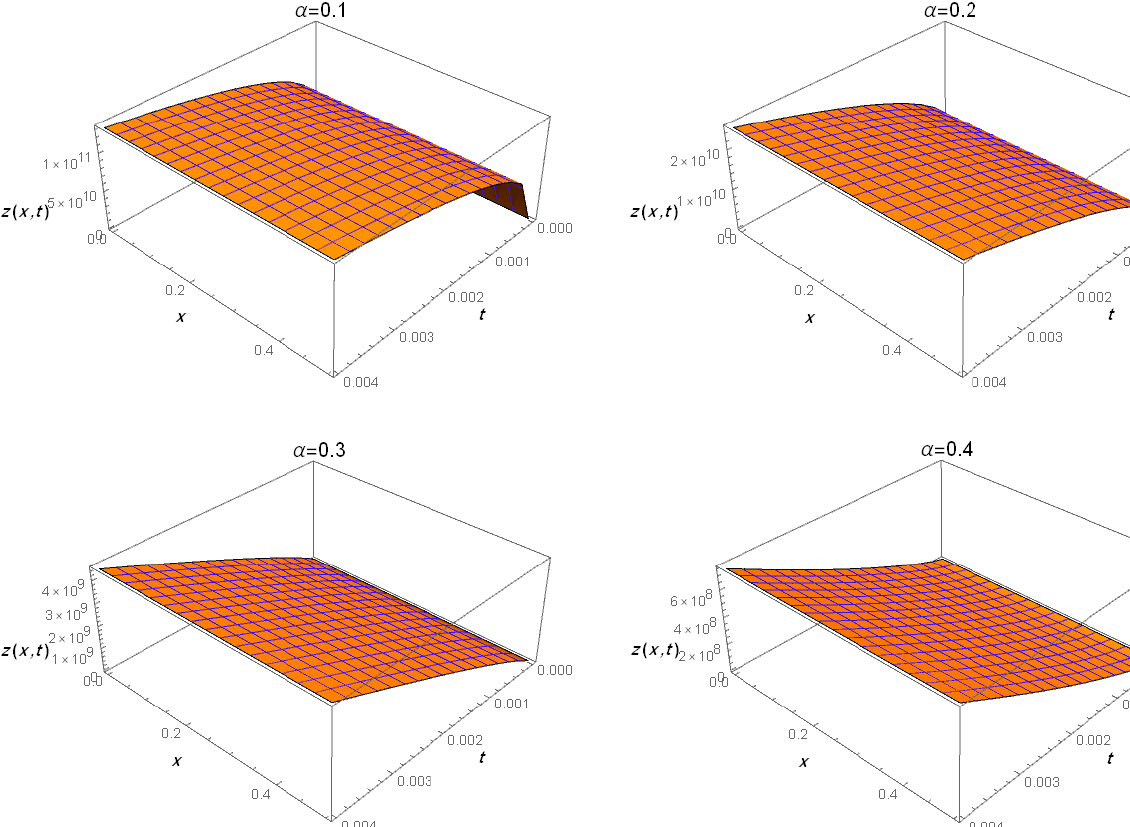
Figure 2. 3D graphs of neutron flux z ( x , t ) for α = 0.1, 0.2, 0.3, 0.4 and z 0 ( x ) = 𝑥 (cid:2870) .